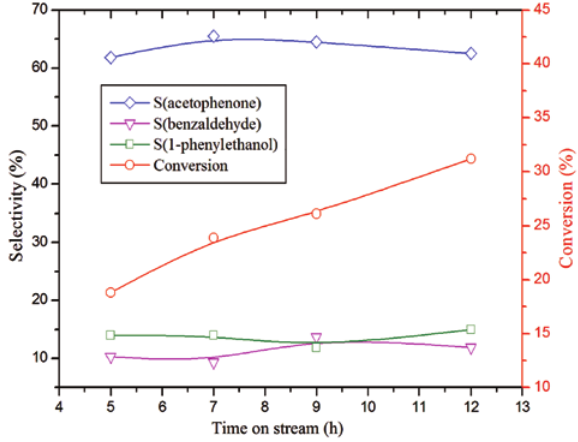
Figure 7: Variation of the conversion and product selectivities with reaction time. Reaction conditions: (H O /ethylbenzene) volume 2 2 ratio = 2.5; P(CO ) = 5.5; m(cat) = 0.75 g and m (co-catalyst) = 0.25 2